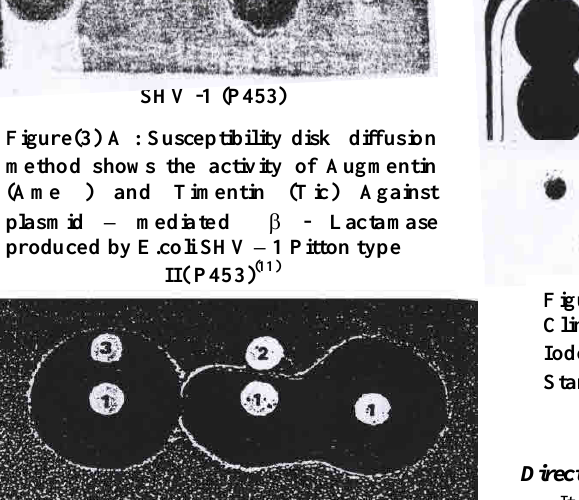
Figure(3) A : Susceptibility disk diffusion method shows the activity of Augmentin (Ame ) and Timentin (Tic) Against plasmid – mediated  - Lactamase produced by E.coli SHV – 1 Pitton type II( P453) (11)